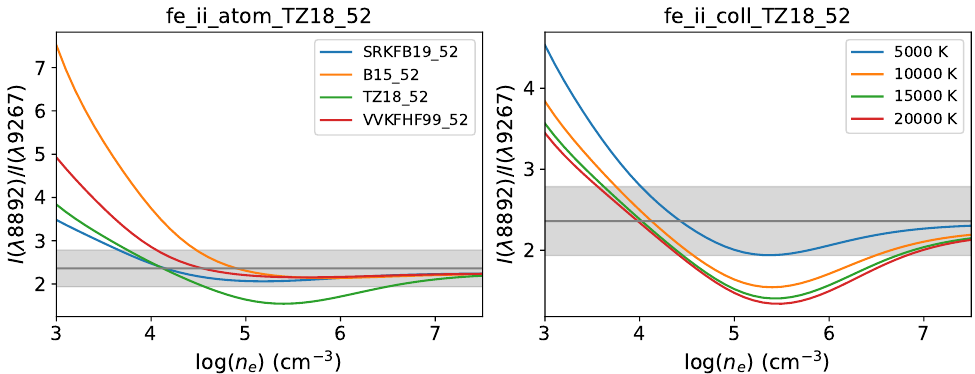
Figure 10. Density behavior of the [Fe II ] I ( λ 8892 ) / I ( λ 9267 ) emissivity ratio using different atomic datasets. The observed ratio in HH202S is 2.36 ± 0.42, which is depicted as a gray band. Left panel : atom_TZ18_52 radiative dataset with four coll datasets (SRKFB19_52, B15_52, TZ18_52, VVKFHF99_52) at T e = 10 4 K. Right panel : atom_TZ18_52 and coll_TZ18_52 datasets at four electron